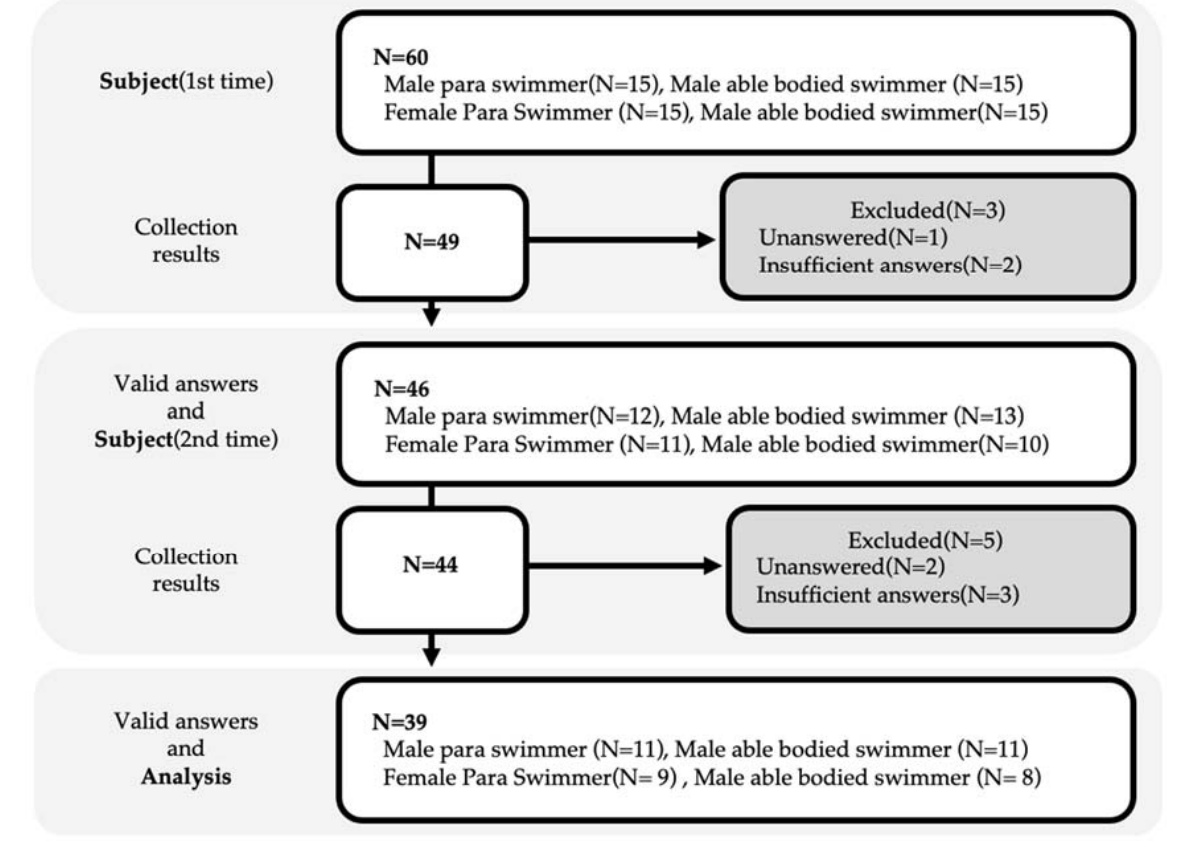
Figure 1. Flowchart with the inclusion/exclusion of participants.